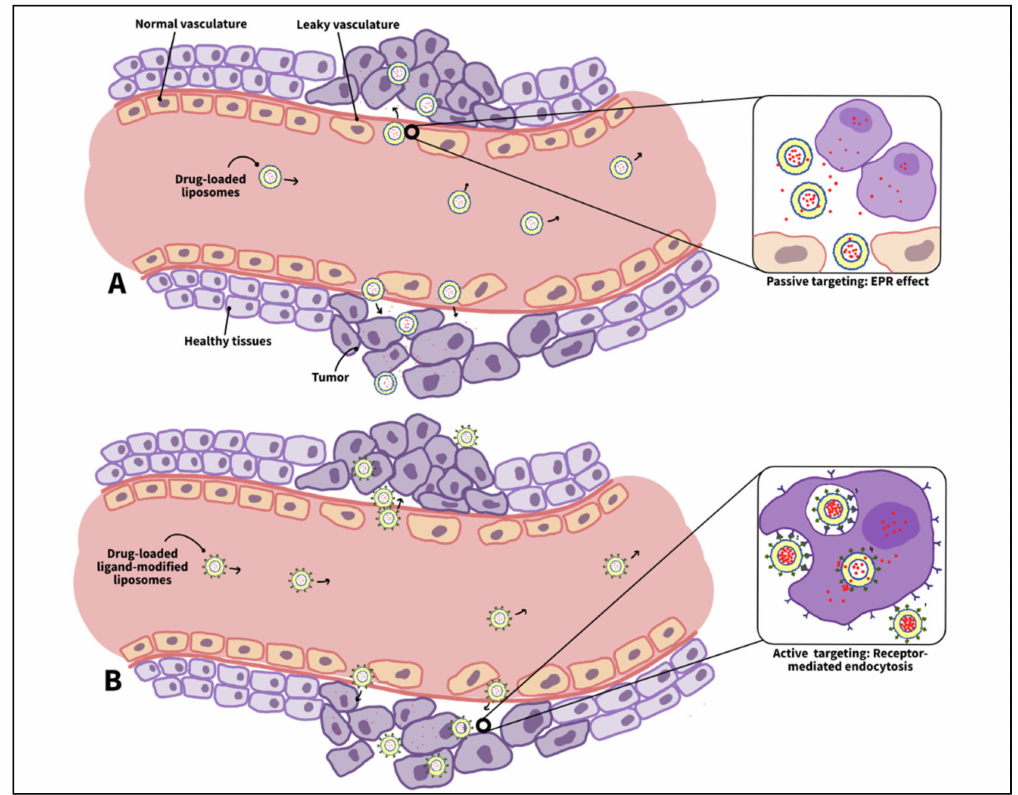
Figure 4. ( A ) Passive targeting. Liposomes leave the blood circulation and accumulate in the tumor vicinity via the EPR effect, which relies on the tumor’s defective vasculature and lymphatic drainage system. Then, the drug diffuses out of the liposomes and enters the cancer cells; ( B ) active targeting. After passive targeting, cancer cells internalize the liposomes via receptor-mediated endocytosis. The latter is induced by the ligand–receptor interactions between cancer cells and